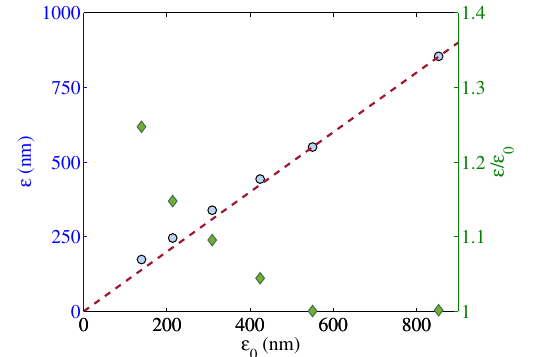
FIG. 14. Simulated horizontal core emittance after compression (left axis) versus initial emittance and corresponding relative increase (right axis). The extrapolation of the core emittance after compression for the limit of zero initial emittance is also shown. The compression factor is fixed to 15.